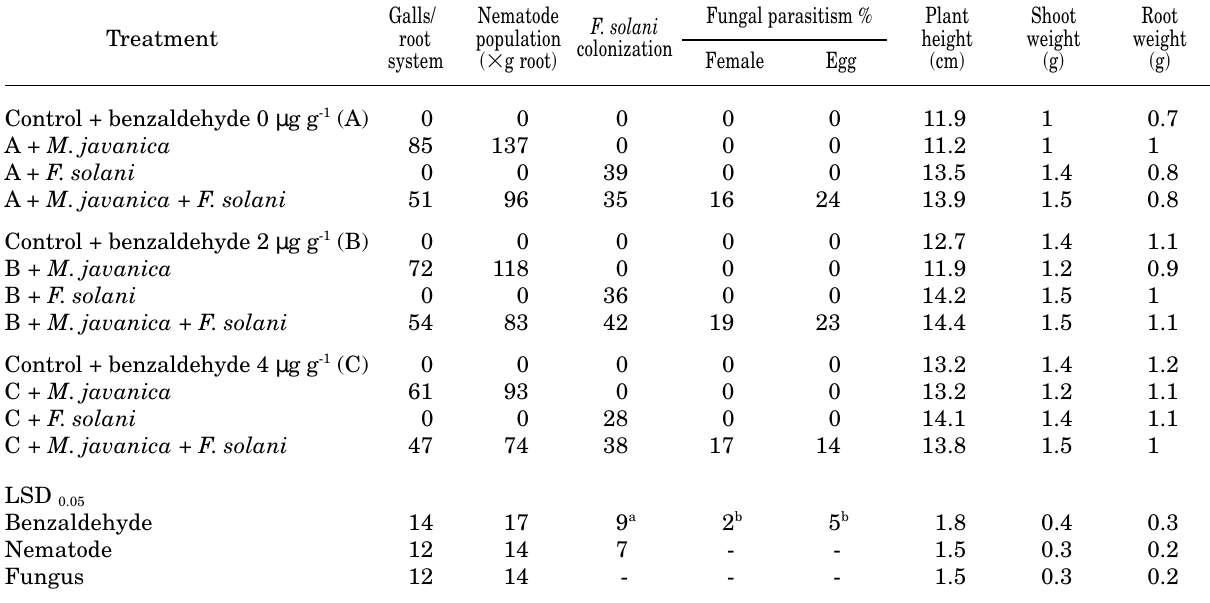
Table 4. Effect of Fusarium solani strain Fs5 at various concentrations of benzaldehyde on Meloidogyne javanica on tomato, as shown by development of root-knot infection, M. javanica invasion, root colonization by F. solani , female and egg parasitism by the fungus, and growth of tomato plants.